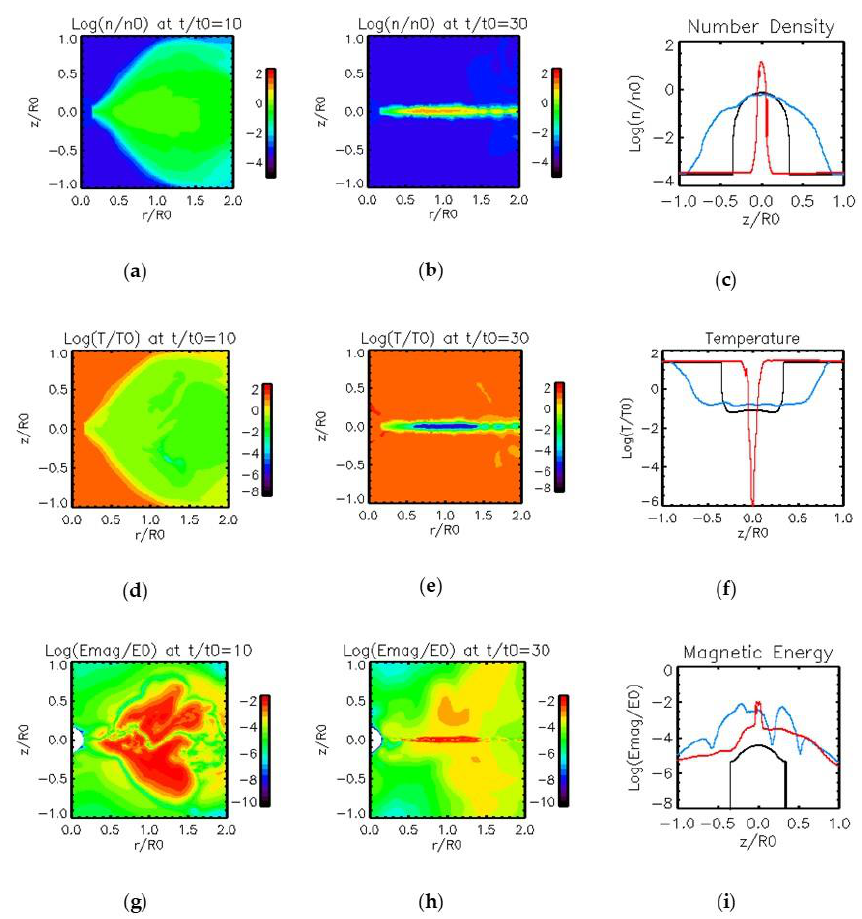
Figure 1. Results of Model 1. ( a ) Distribution of number density at t / t 0 = 10 before cooling term is included. ( b ) Distribution of number density at t / t 0 = 30. ( c ) Vertical distribution of number density at three different time and at r / R 0 = 0.8. Black line shows initial condition at t / t 0 = 0. Blue line shows result at t / t 0 = 10. Red line shows result at t / t 0 = 30. ( d ) Distribution of temperature at t / t 0 = 10. ( e ) Distribution of temperature at t / t 0 = 30. ( f ) Vertical distribution of temperature. Color scale is the same as (c). ( g ) Distribution of magnetic energy density ( B / B 0 ) 2 /8 π at t / t 0 = 10. ( h ) Distribution of magnetic energy density at t / t 0 = 30. ( i ) Vertical distribution of magnetic energy density. Colors have the same meaning as ( c ) and ( f ).